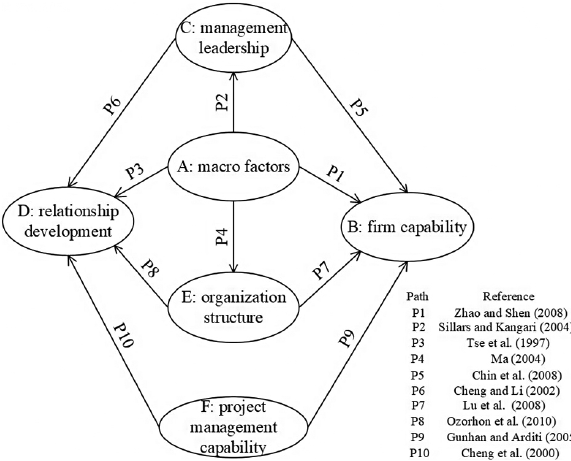
Figure 2. The hypothetical relationship among factor